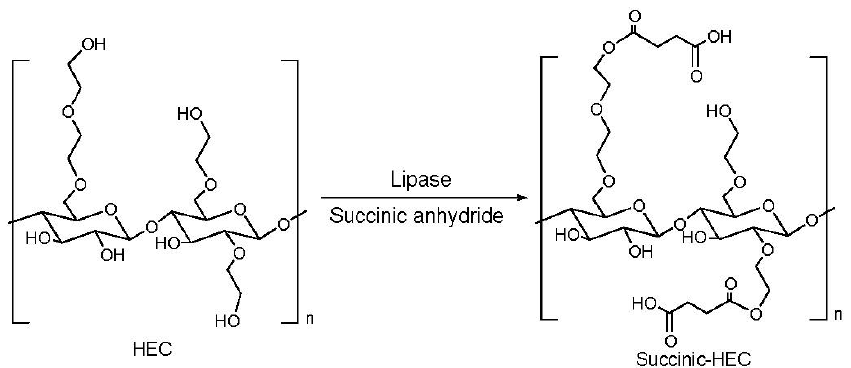
Figure 3. Synthesis of succinated HEC.